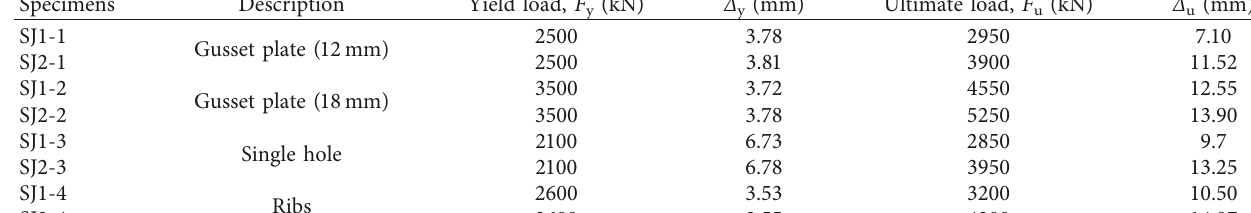
Table 3: The main results of the tests.